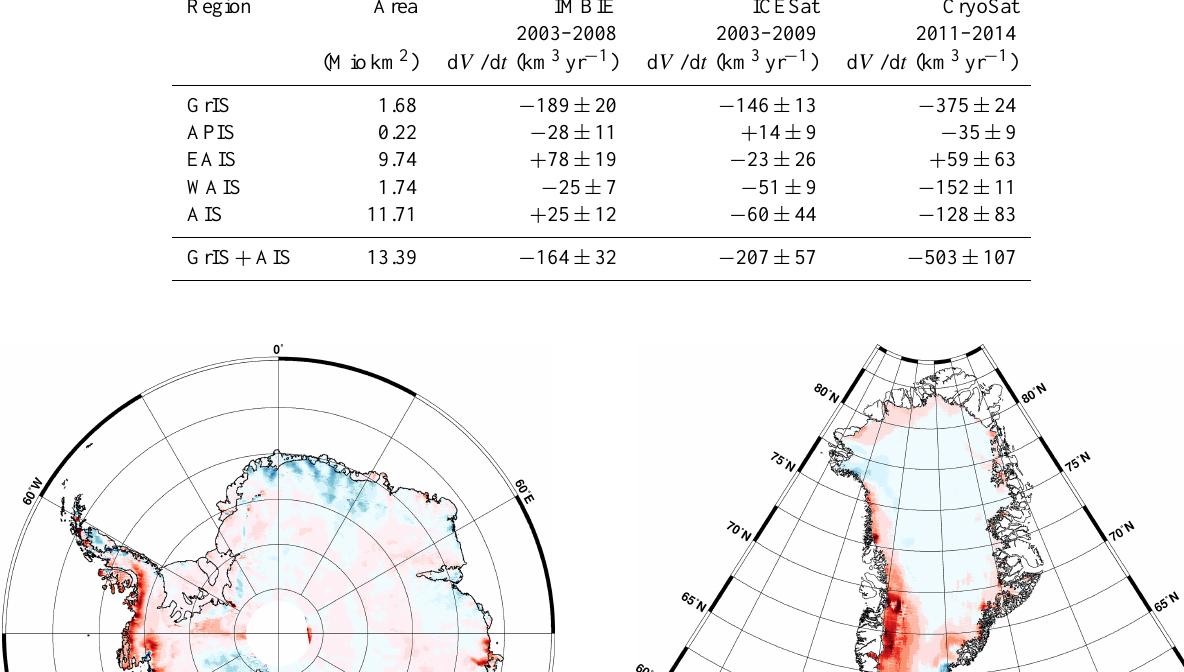
Table 4. Volume rate estimates of ICESat and CryoSat-2 derived in this study compared with ICESat from IMBIE (Shepherd et al., 2012). Region Area IMBIE ICESat CryoSat